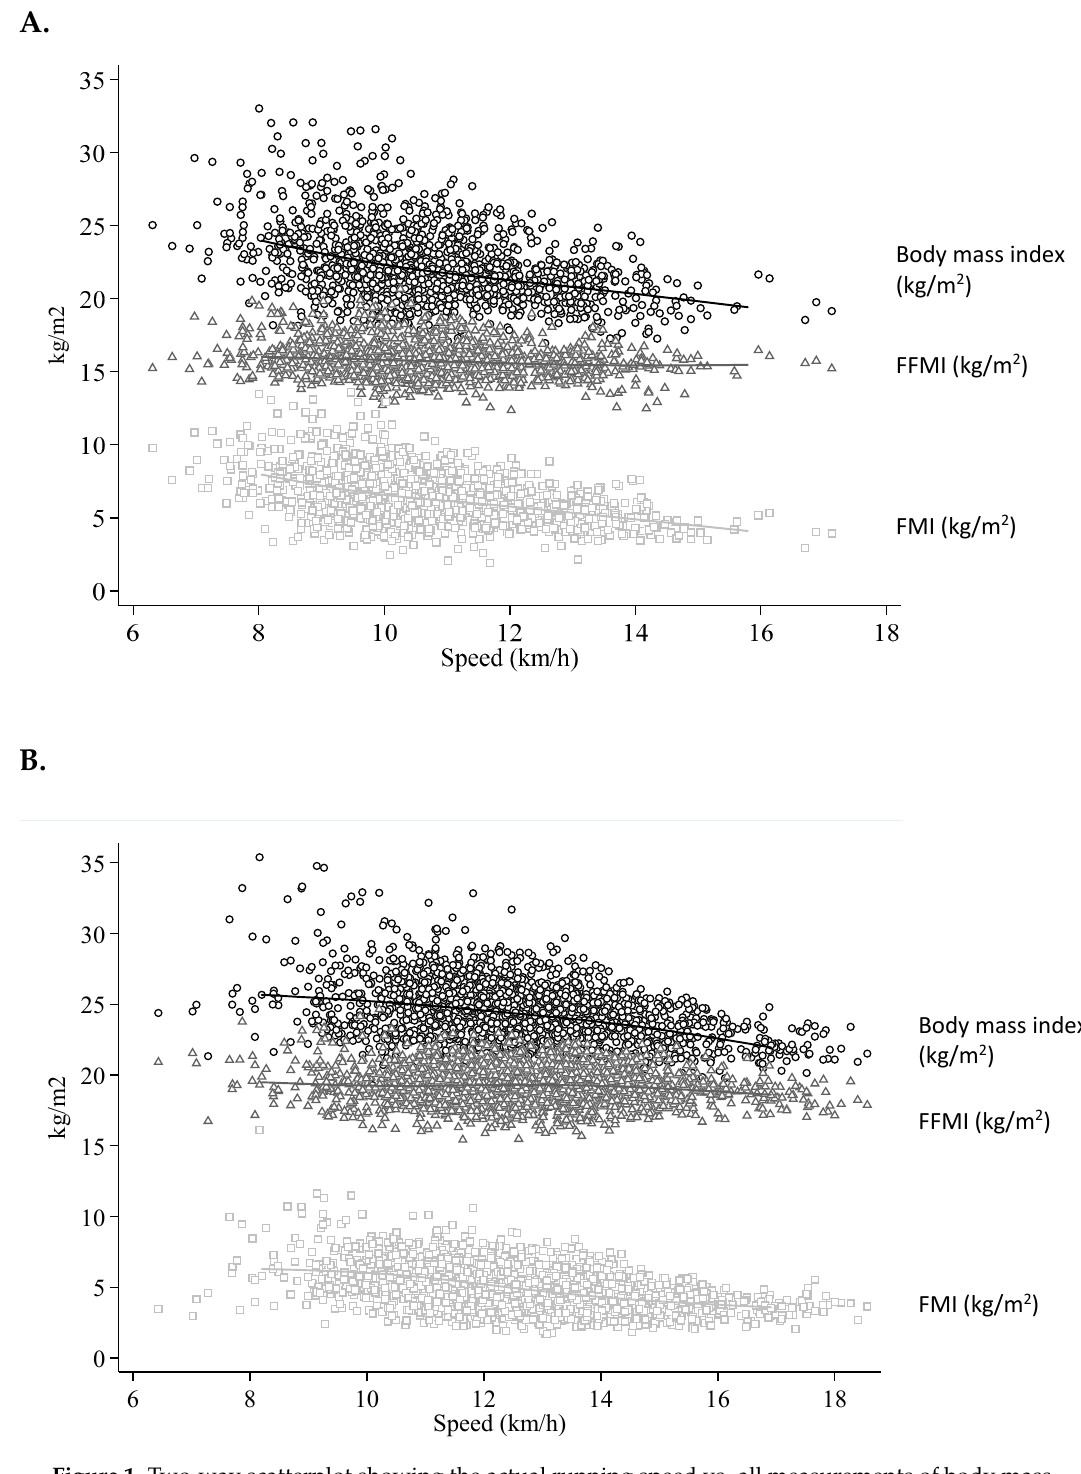
Figure 1. Two-way scatterplot showing the actual running speed vs. all measurements of body mass index ( ○ ), fat-free mass index ( Δ ) and fat mass index ( □ ) in women ( A ; 377 women, 1419 observations) and men ( B ; 509 men, 2161 observations].